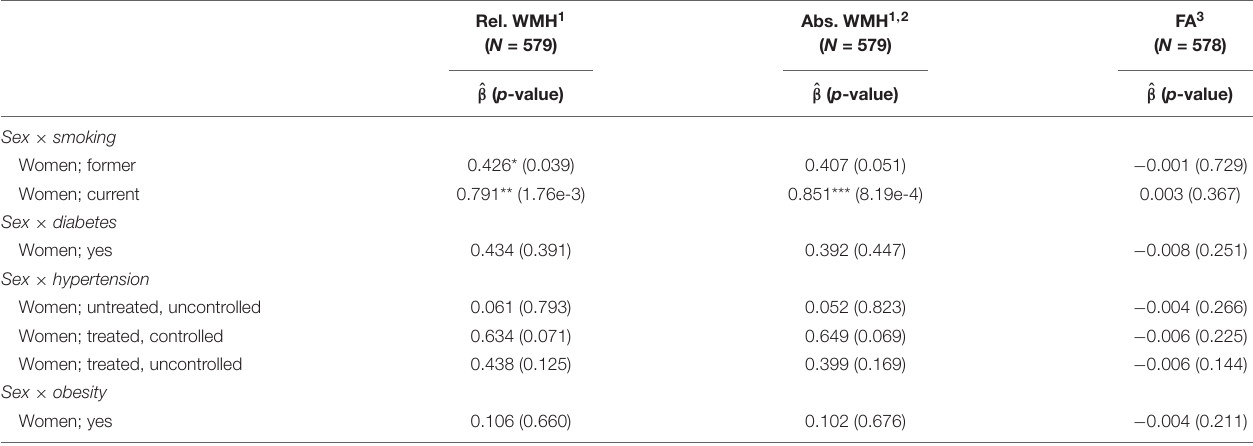
TABLE 3 | Moderation effects of sex on the association of potential risk factors with WMH and